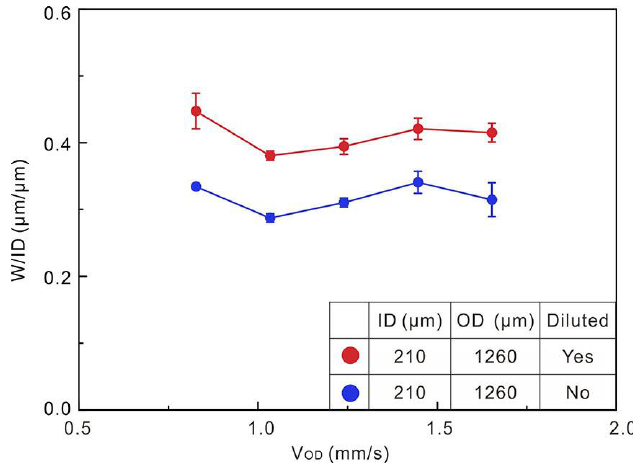
Figure 8. Trace widths normalized by ID as a function of outer channel flow speed with and without diluted outer flow (Q ID = 8 μL/min, V P = 40